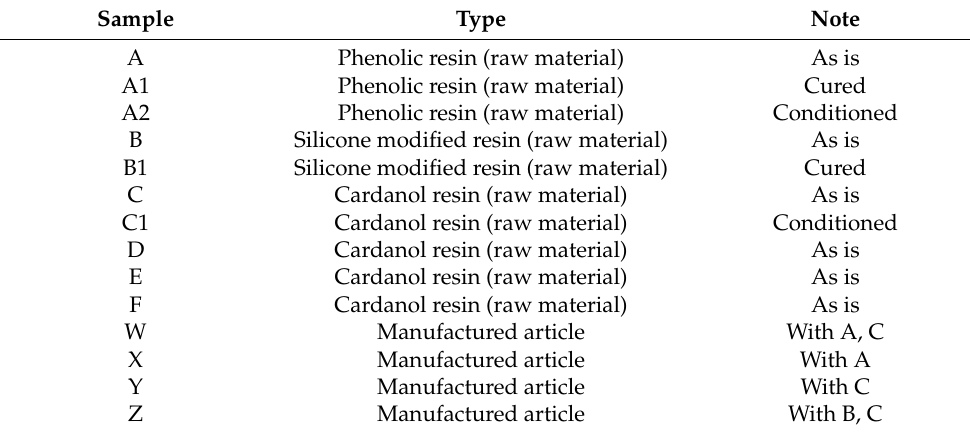
Table 1. List of samples